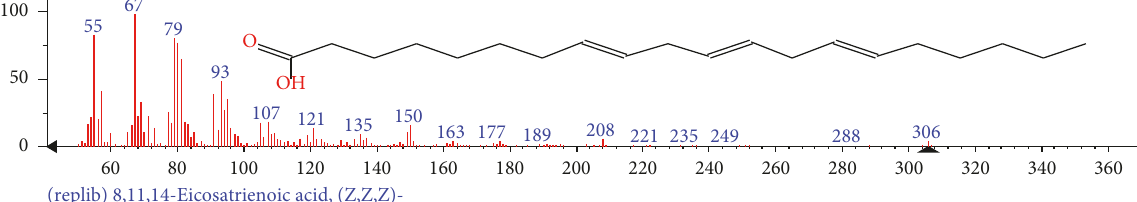
(Z,Z,Z)-60 80 (replib) 8,11,14-Eicosatrienoic acid, Figure 56: Mass spectrum of compound 8,11,14-eicosatrienoic acid, (Z,Z,Z)- of whole plant hexane fraction of Achillea wilhelmsii (WHFAW).